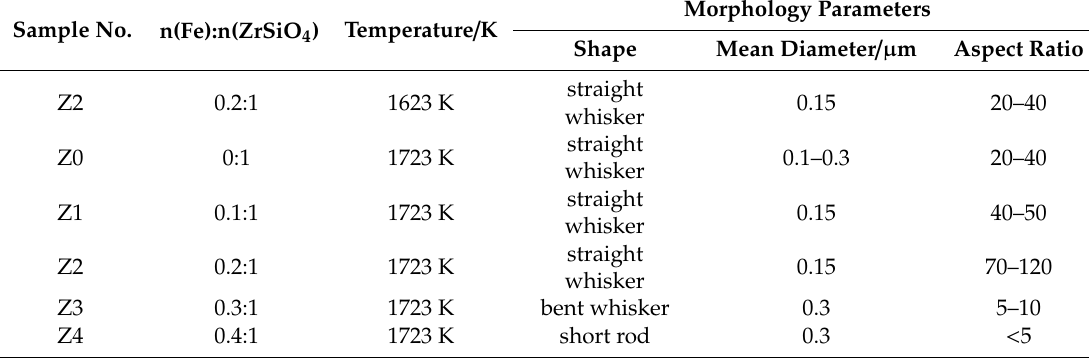
Table 3. Morphology parameters of SiC whiskers in samples as shown in Figure 6. Sample